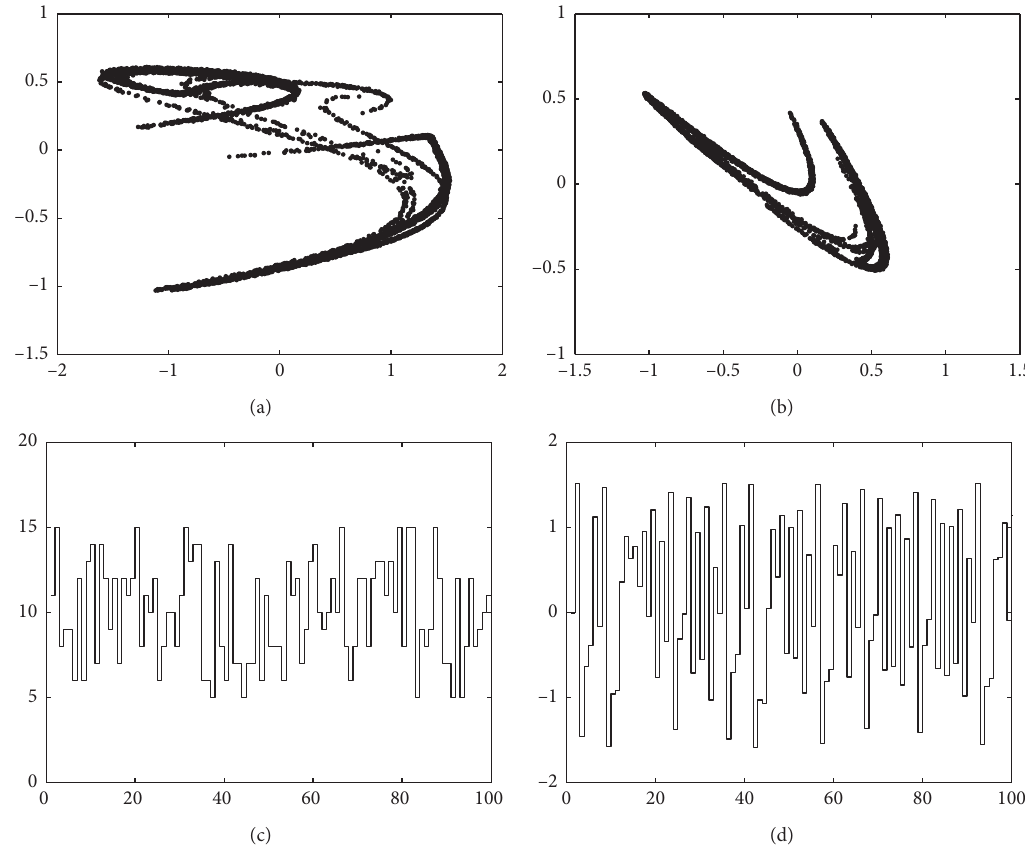
Figure 1: (a) x chaotic system example.